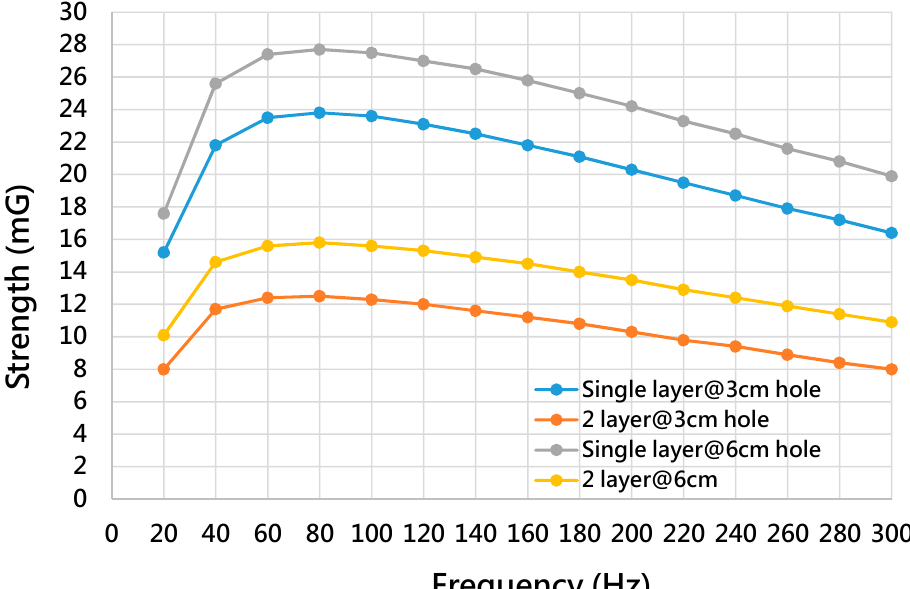
14 of 17 Figure 11. The magnetic strength of the multi-layer structure of the shielding box without holes. Table 10. The comparisons of shielding capability for the PMCS for the multi-layer structures with-